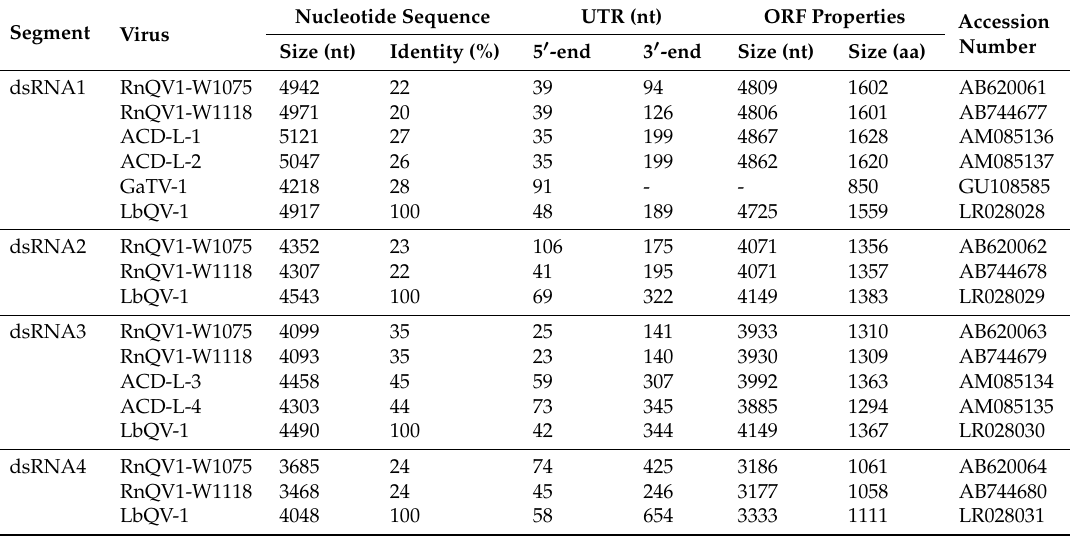
Table 1. Features of the LbQV-1 dsRNA segments 1–4 and comparisons with other known and suspected